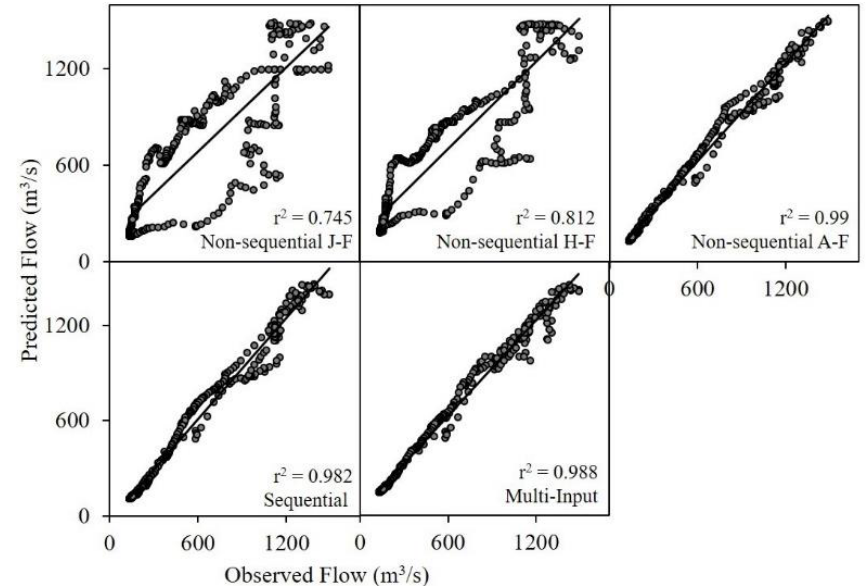
Figure 7. Scatter plots showing the correlation between measured and predicted flow for the ANFIS models for Approach 1.